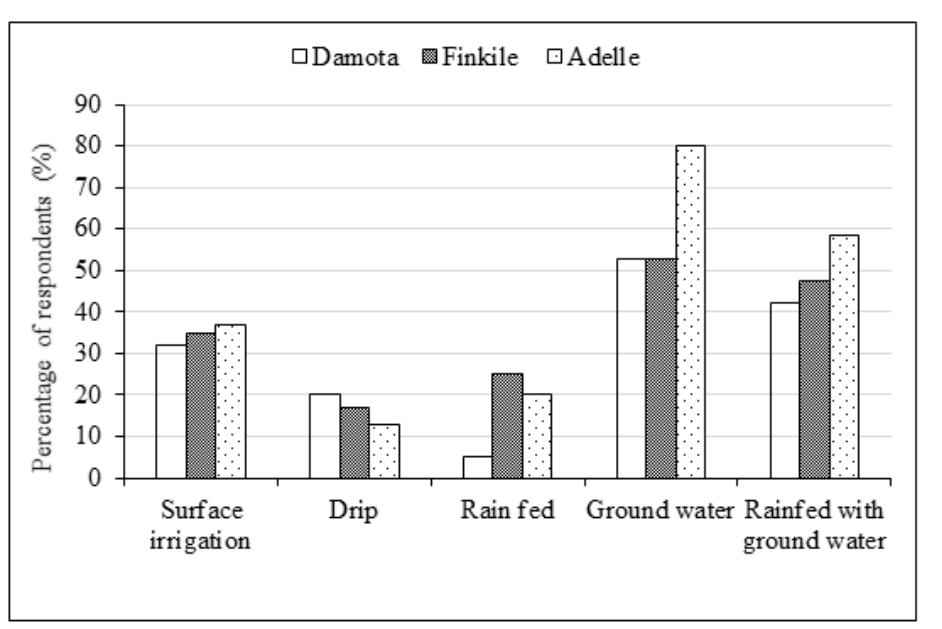
Figure 7. Types of irrigation systems practiced in the three selected kebeles of the Haramaya District (Source: Elaborated by the Authors). (Source: Elaborated by the